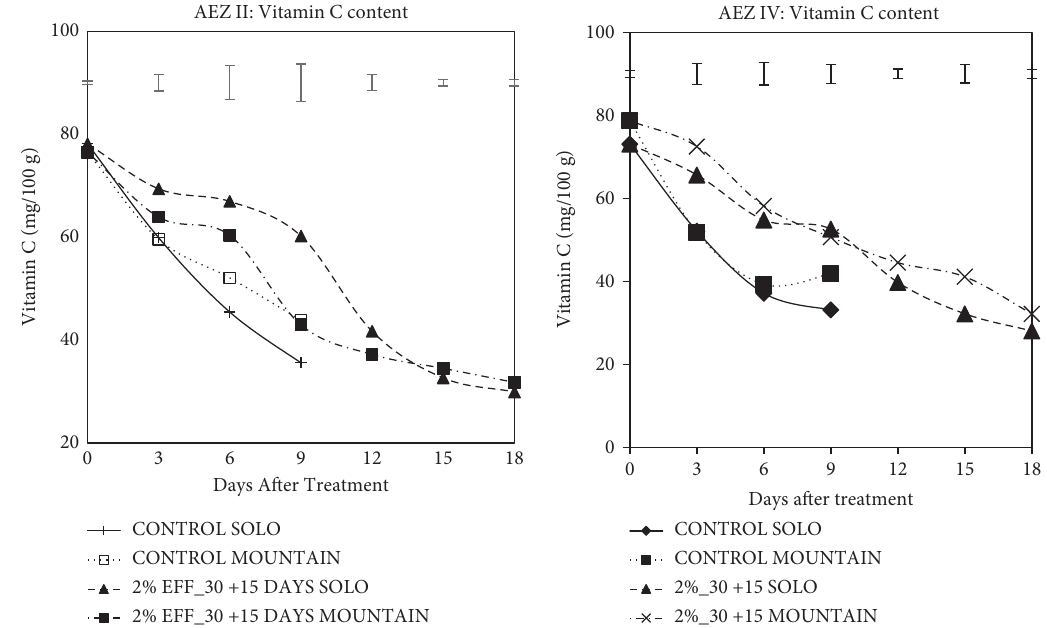
Figure 10: Vitamin C content of papaya fruits treated with Hexanal spray from Machakos and Meru counties. Top bars represent LSD at